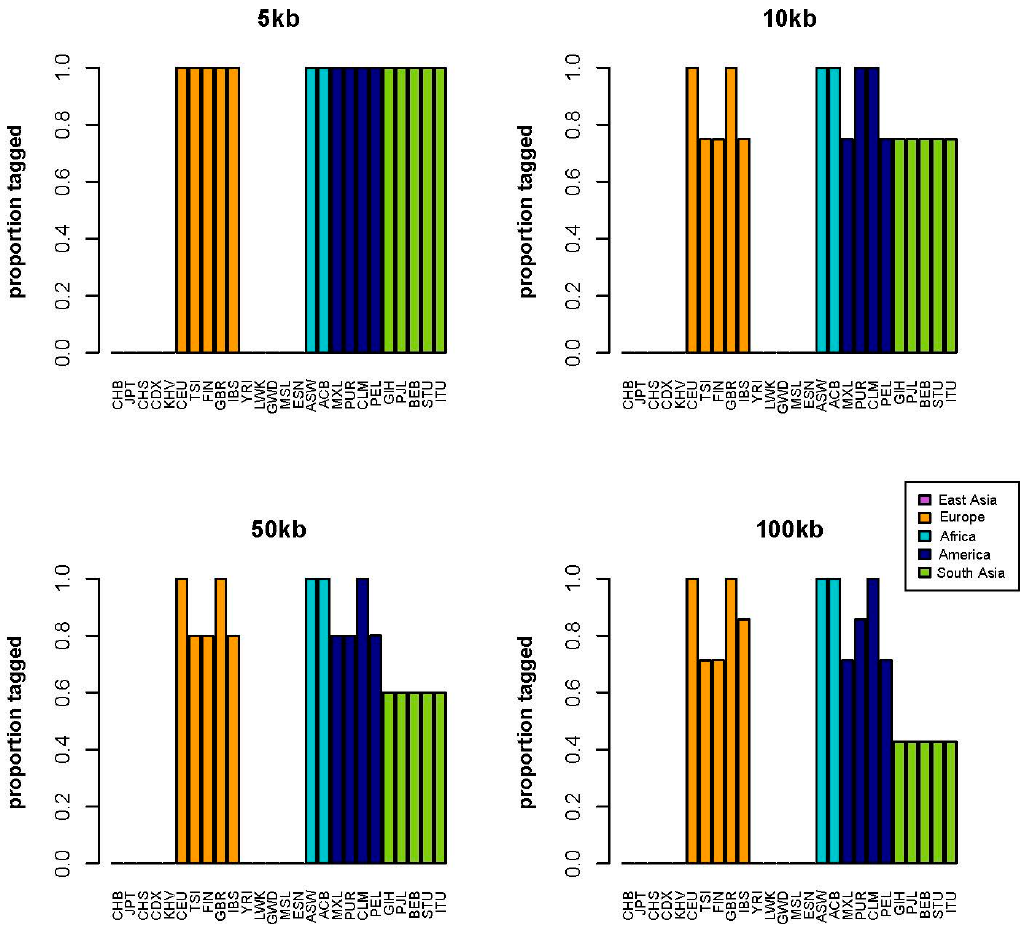
Figure 2. Melanoma genetic risk tag SNP performance. Figure 2 displays four distance windows, each showing the proportion of correctly ( R 2 ≥ 0.08) tagged functional variants on the y -axis and each 1000 Genomes population sample on the x -axis. Population samples are color coded by continental region such that East Asia is purple, Europe is orange, Africa is turquoise, America is dark blue, and South Asia is green. Explanation of population sample abbreviations for the x -axis are shown in Table S1.